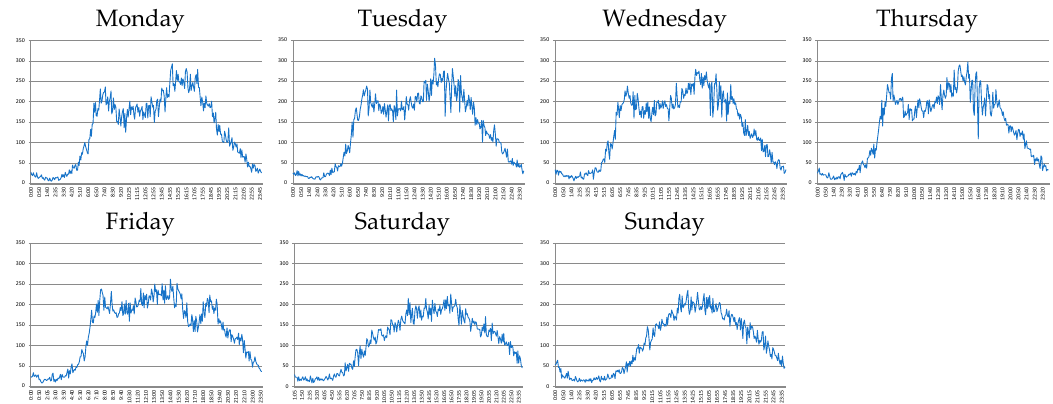
Figure 4. The estimated volume matches the real one perfectly.